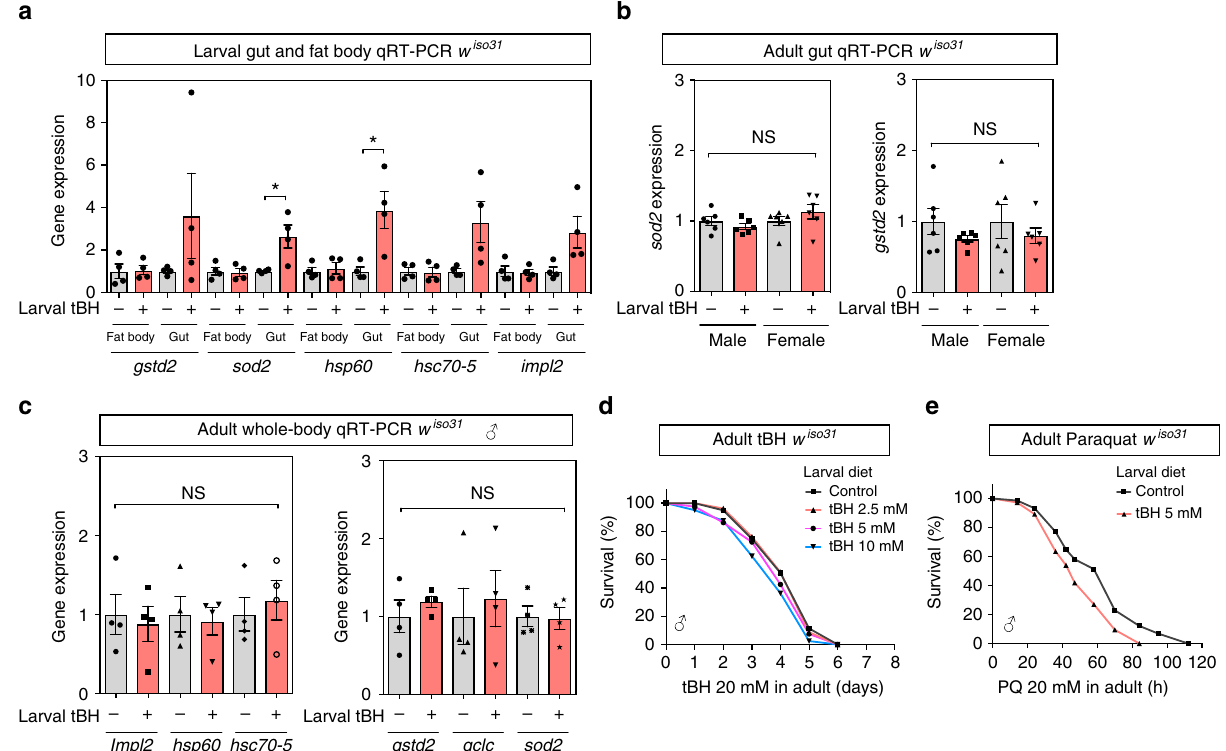
Fig. 2 Larval tBH exposure induces oxidative stress and mitochondrial unfolded protein responses in larval gut but not in larval fat body or adult body. a Quantitative RT-PCR analysis of genes involved in the oxidative stress response ( gstd2 and sod2 ), the mitochondrial unfolded protein response ( hsp60 and hsc70-5 ) and Impl2 in fat body or gut of w iso31 larvae. Mean ± SEM ( n = 4). b Quantitative RT-PCR analysis of sod2 and gstd2 in the adult gut of w iso31 male or female fl ies. Mean ± SEM ( n = 6). c qRT-PCR analysis in whole body of w iso31 male fl ies. Mean ± SEM ( n = 4). d , e Survival curves of w iso31 male